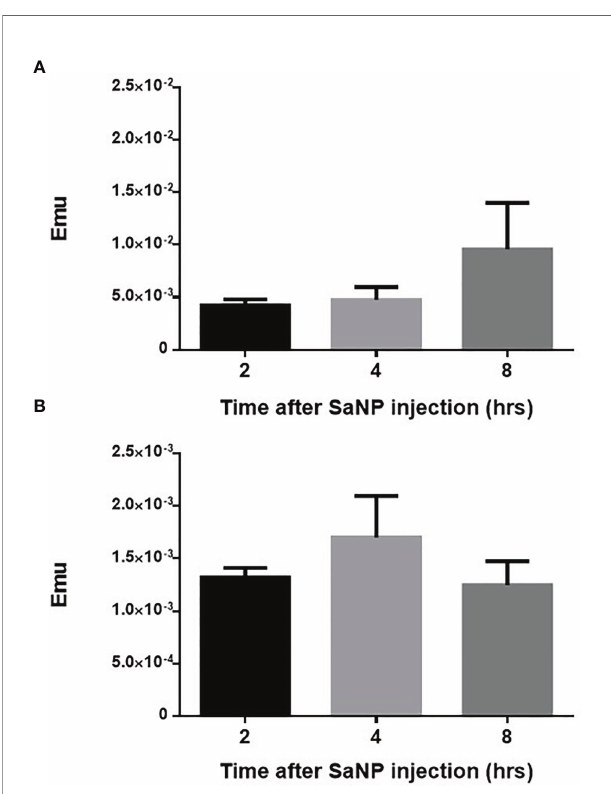
FIGURE 2 | Biodistribution of SaNPs in the lung metastases and blood. (A) SaNP accumulation in the lungs of BALB/c mice-bearing 4T1 metastases at 2, 4, and 8hrs post injection. (B) SaNP accumulation in the blood at 2, 4, and 8hrs post injection. Samples were analyzed by SQUID for the quantitation of IO content. Results are expressed as mean ± S.D. electromagnetic units (EMU).